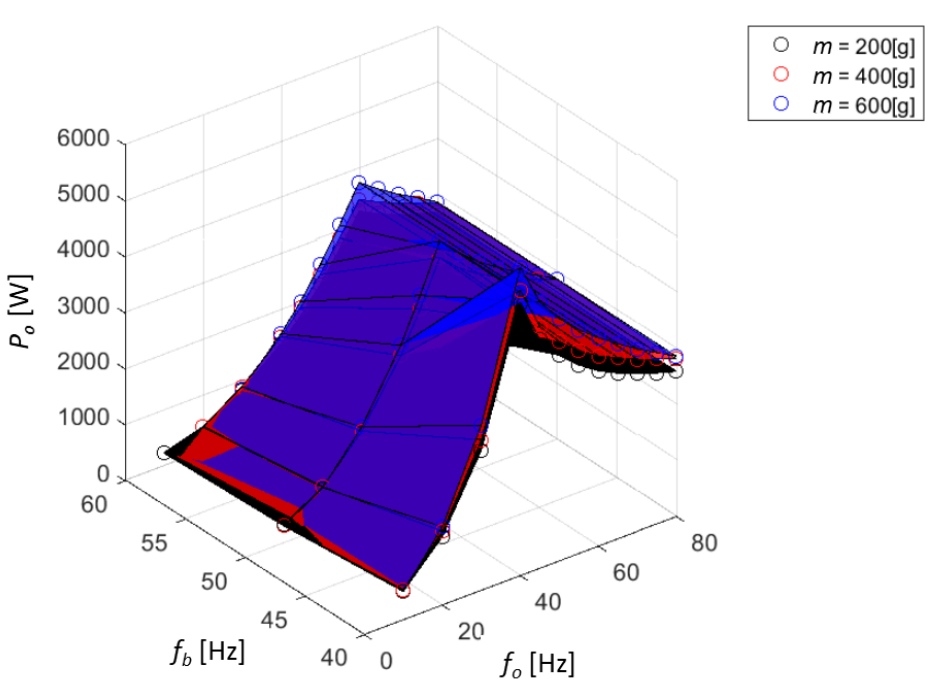
Figure 4. Static characteristic of the active power versus output and basic frequencies obtained for different mass of grinding medium.